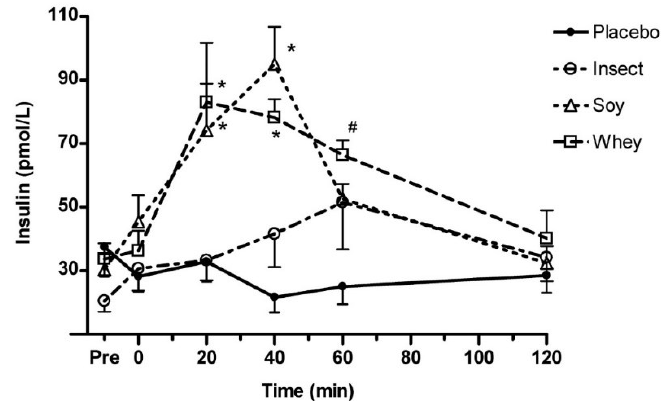
Figure 3. Serum insulin concentration after ingestion of whey, soy, insect, or placebo. Blood samples were obtained pre and 0, 20, 40, 60, and 120 min post-prandial. * Significant different from insect isolate ( p < 0.05), # significant different from soy isolate for same condition ( p < 0.05). All values are mean ± SD; n = 6 per group.